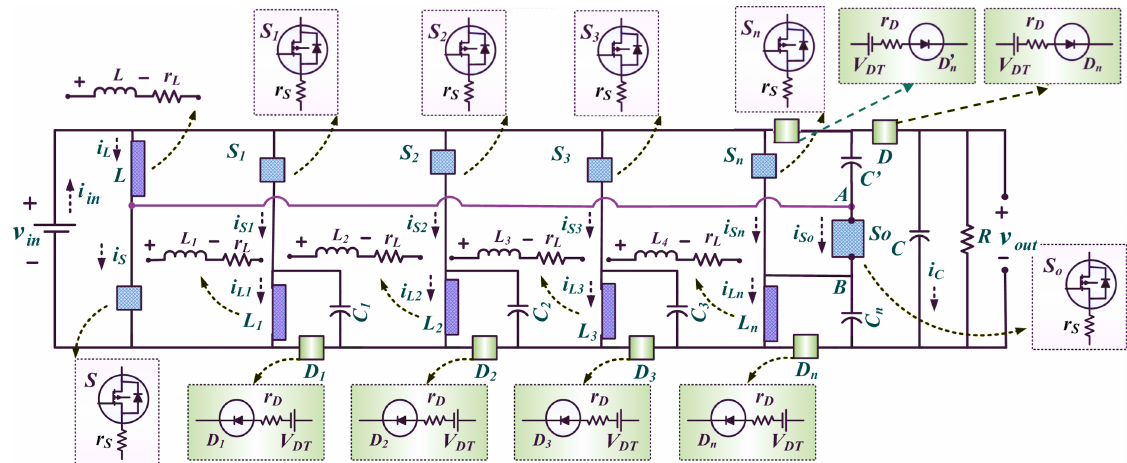
Figure 8. ML converter with